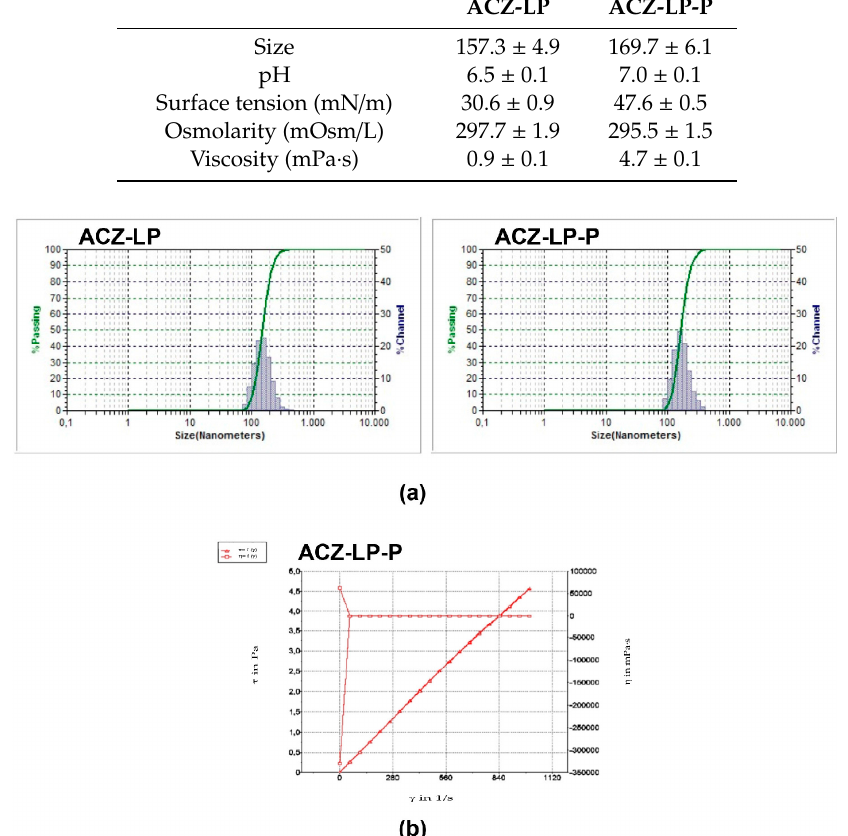
Table 2. Mean particle size, pH, surface tension, osmolarity, and viscosity data of the ACZ liposomal formulations. Data are expressed as means ± standard error.